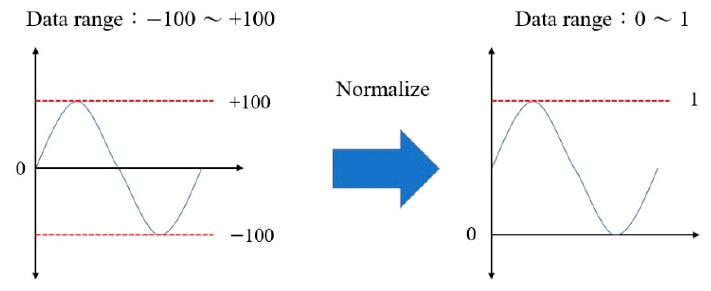
Figure 3. Conceptual representation of data normalization.